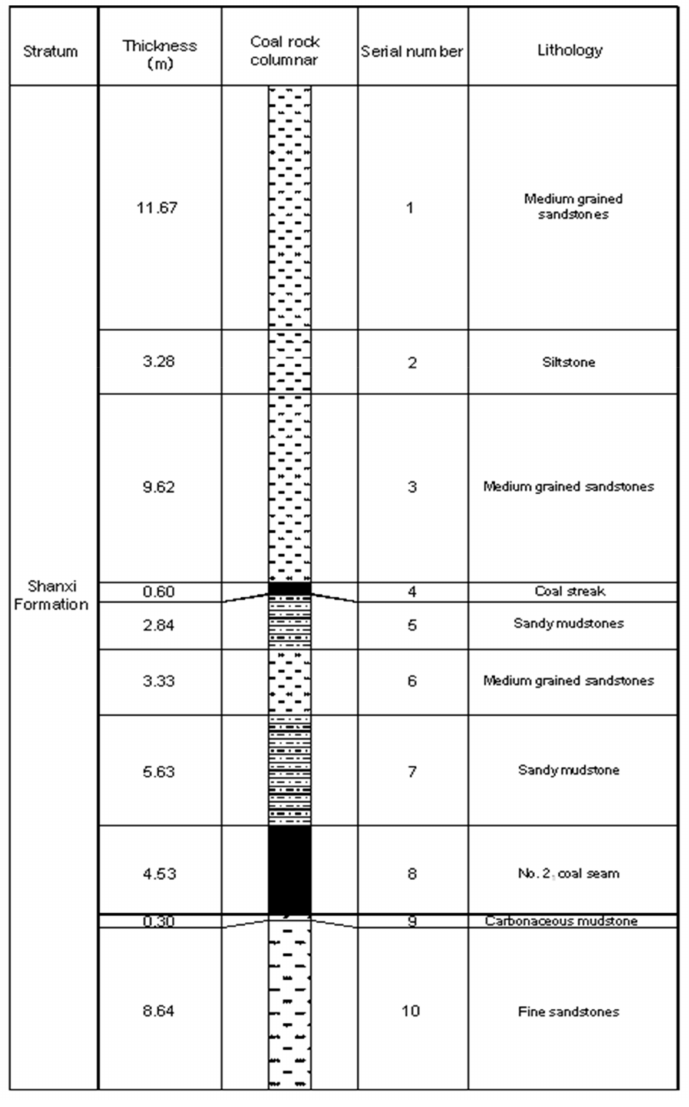
Figure 2. Comprehensive stratigraphic column of the Shanxi Formation